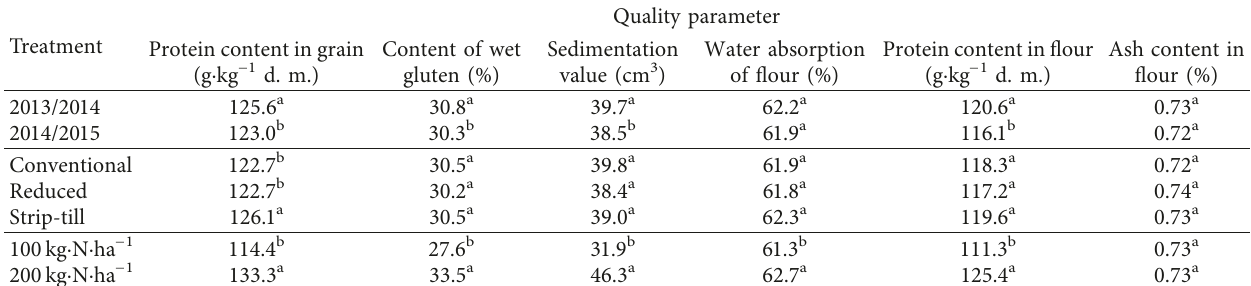
Quality parameter